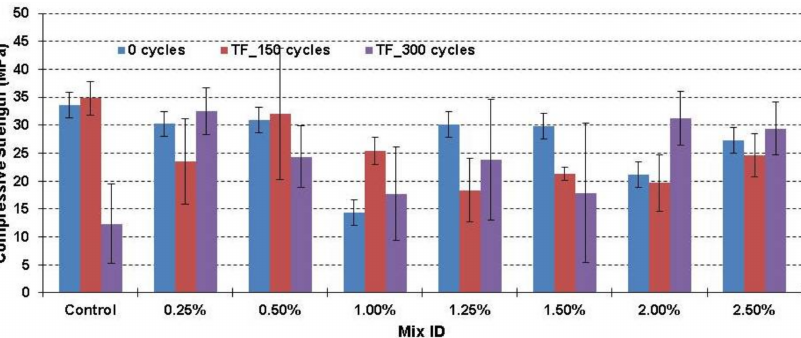
Figure 7. Compressive Strength Results due to Thermal Fatigue